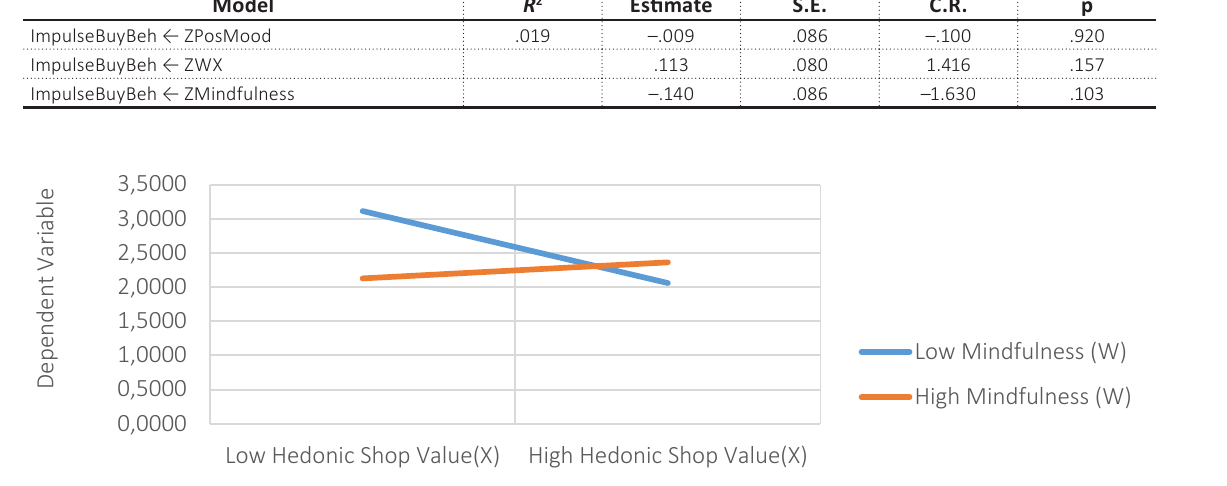
Figure 4. Interaction graph of hedonic shopping value with mindfulness